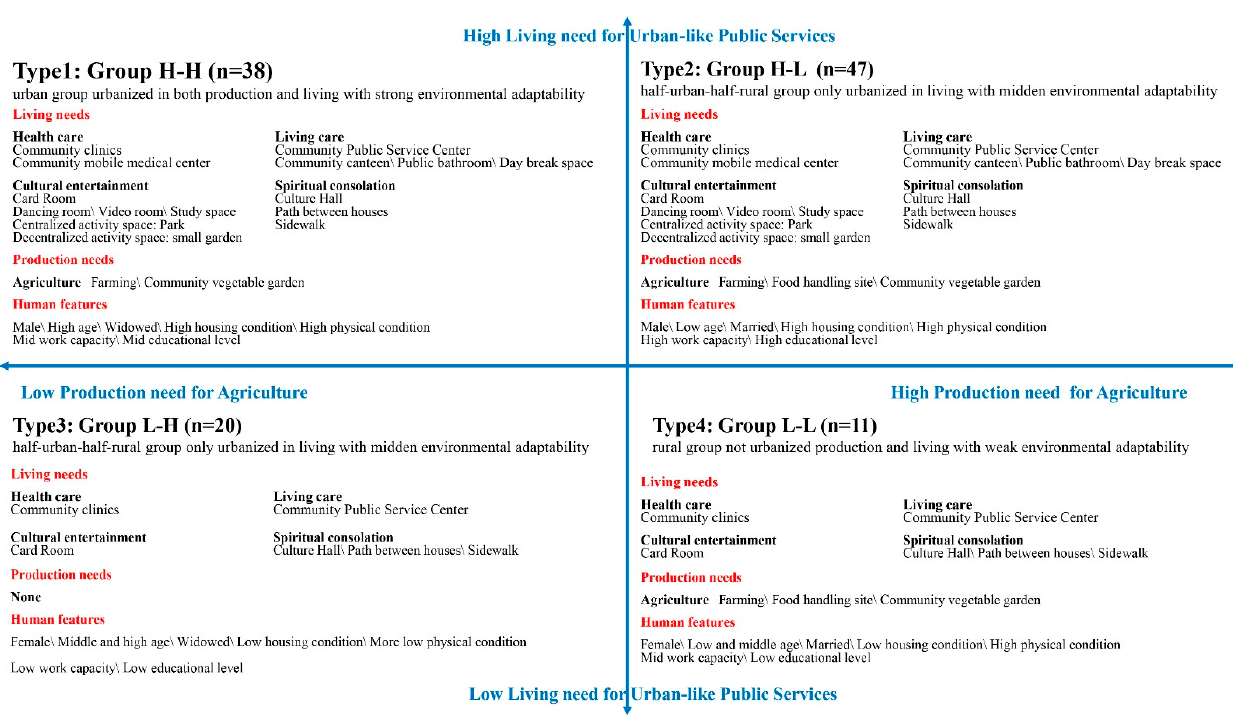
Figure 6. Model of urbanization characteristics (Source: